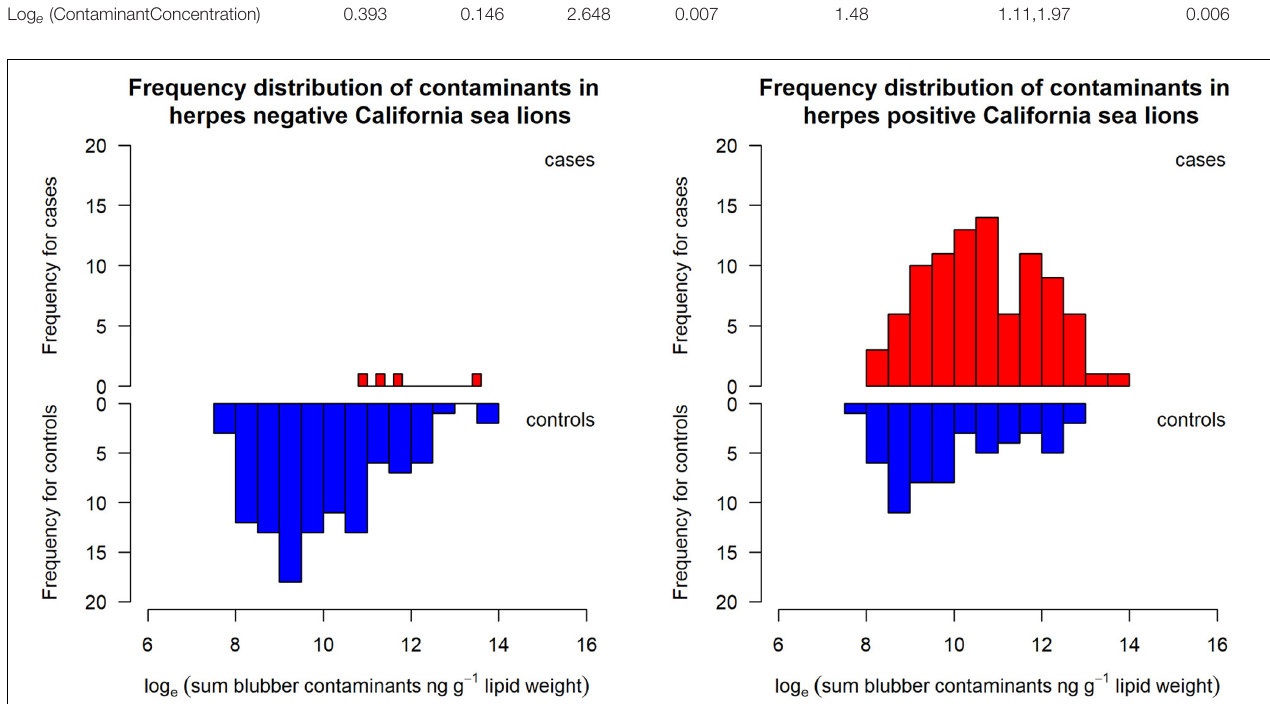
FIGURE 3 | Distribution of blubber contaminant concentrations in herpesvirus negative (left panel) and herpesvirus positive (right panel) sea lions with (cases) (red) and without (controls) (blue) cancer. Note only four animals with cancer that also had contaminant data were negative for herpesvirus.